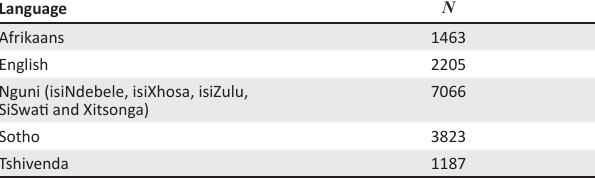
TABLE 2: Number of Grade 4 prePIRLS 2011 students tested by language